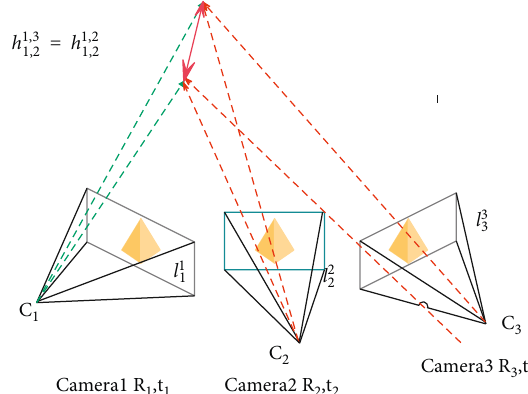
Figure 6: Pairwise correct matching results in a spatially consistent three-dimensional line segment